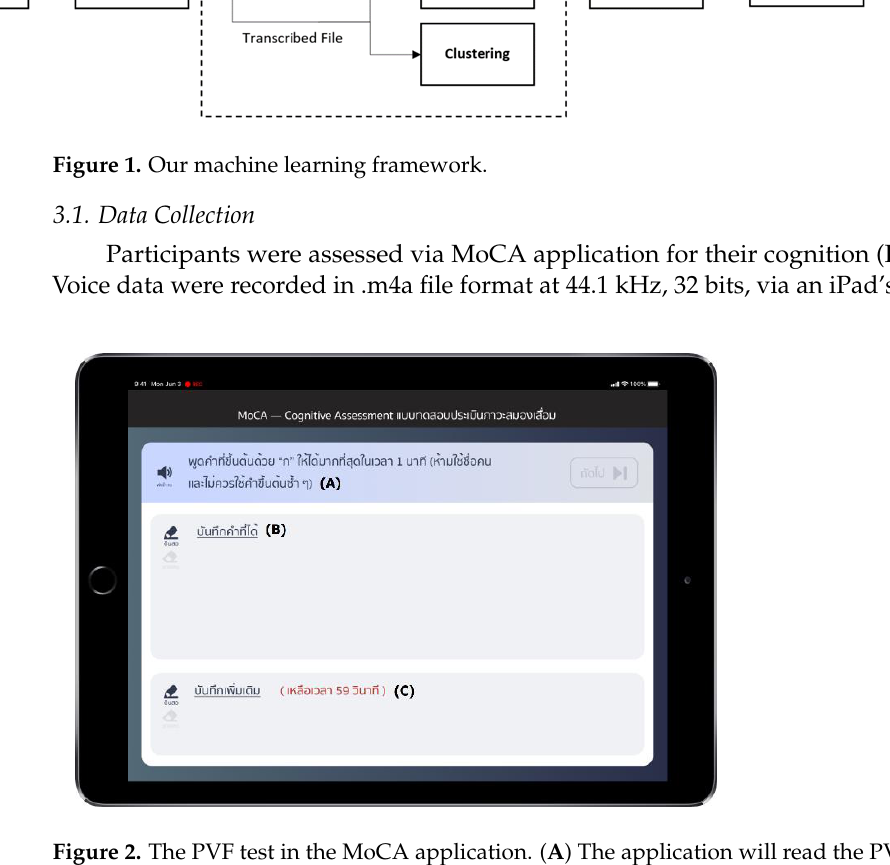
Figure 1. Our machine learning framework.